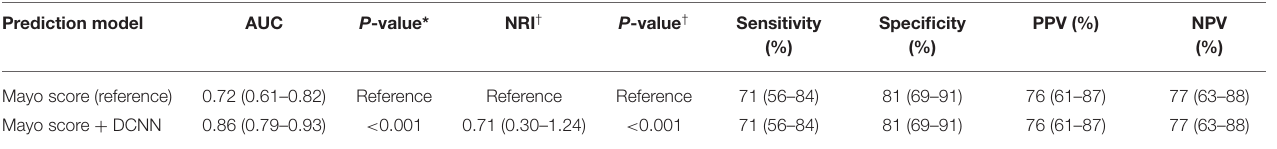
TABLE 2 | Predictive performance of Mayo score and a new model combining Mayo score and deep convolutional neural network-based probability to predict positive genotype in patients with hypertrophic cardiomyopathy. Prediction